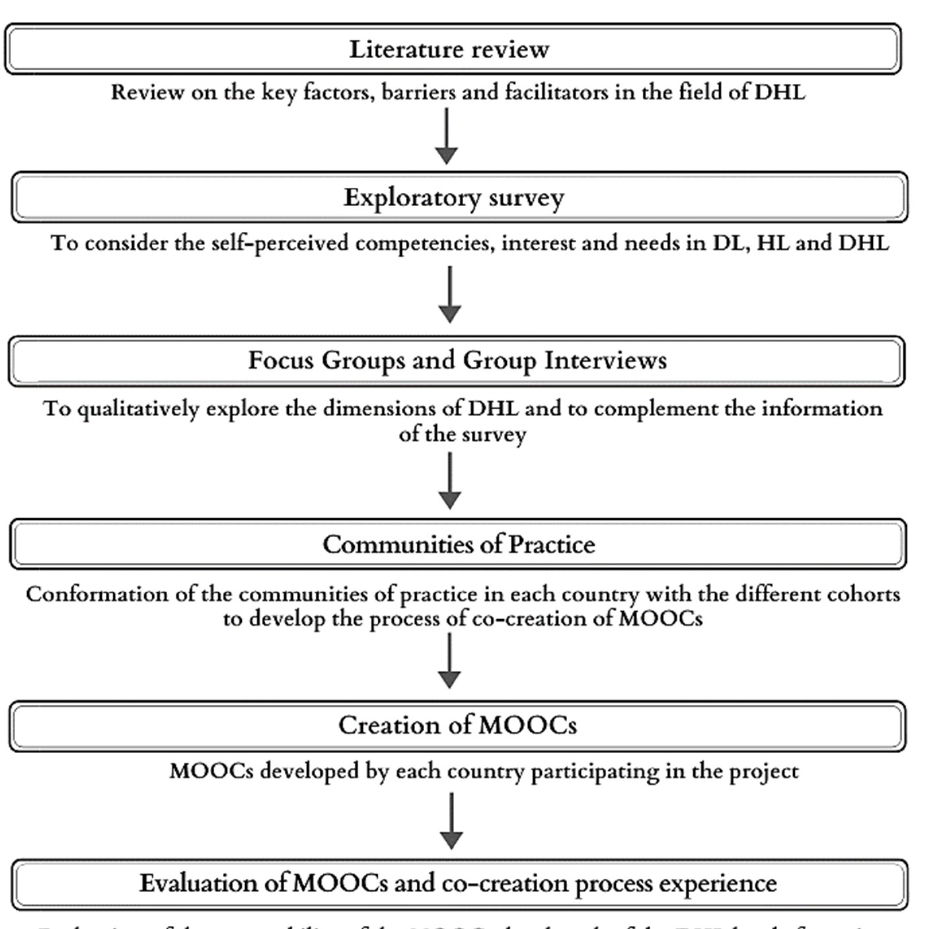
Figure 1. Procedure of IC-Health project.